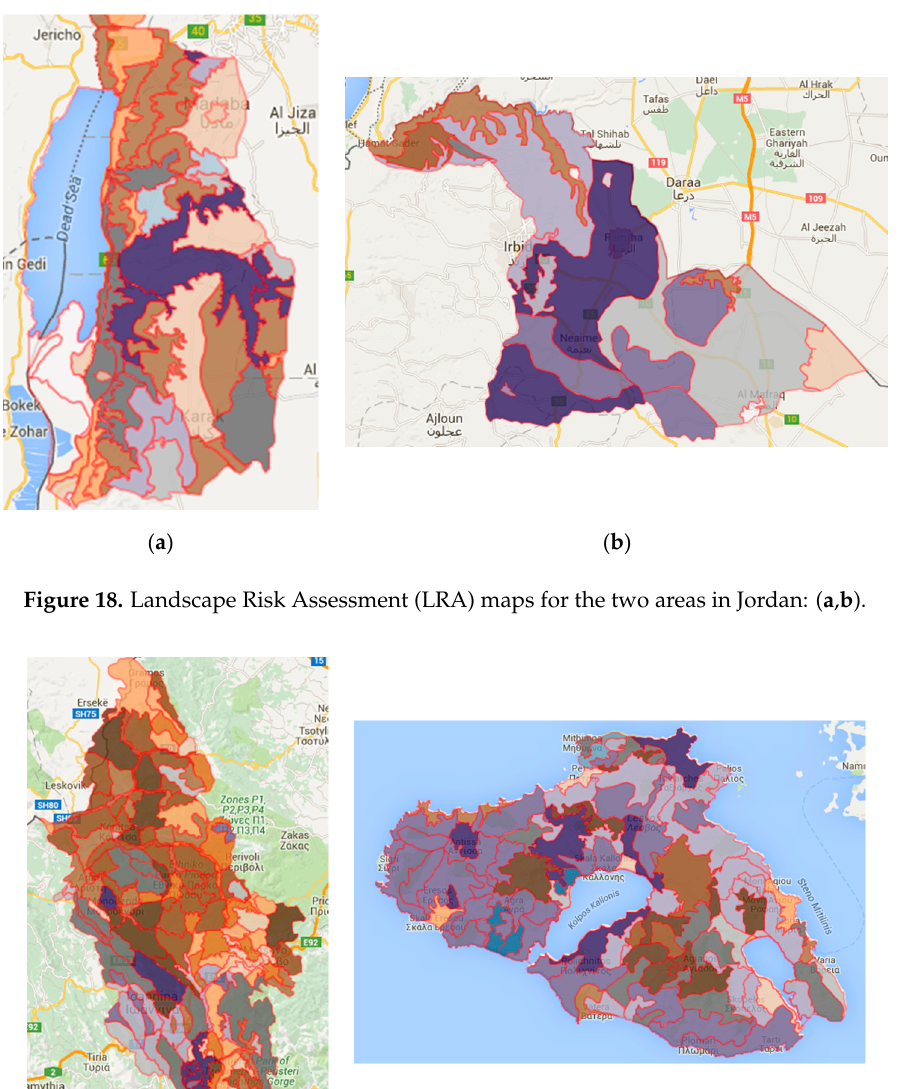
Figure 17. Landscape Risk Assessment (LRA) maps for Lebanon ( a ) and Cyprus ( b ).